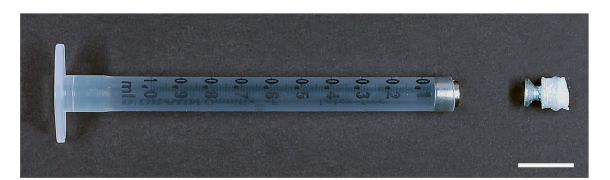
FIGURE 1 | Image of a prototype to mount a large specimen. The tip of a 1 mL syringe (BD Biosciences) is cut off and a magnet is introduced. This can then hold a specimen attached with glue via a adapter, here a 3D printed PLA block attached to a flat head steel screw. Scale bar: 1